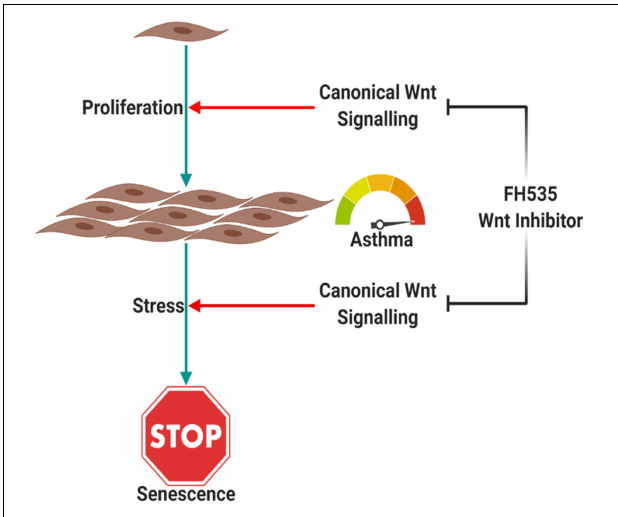
FIGURE 16 | Schematic representation of the possible role of canonical | Wnt signaling on bronchial fibroblast senescence. Canonical Wnt signaling is needed for the proper response of cells to proliferative stimuli, which puts cells under stress. Cells in response to proliferative stress will activate senescence, which is dependent on Wnt signaling too. Created with